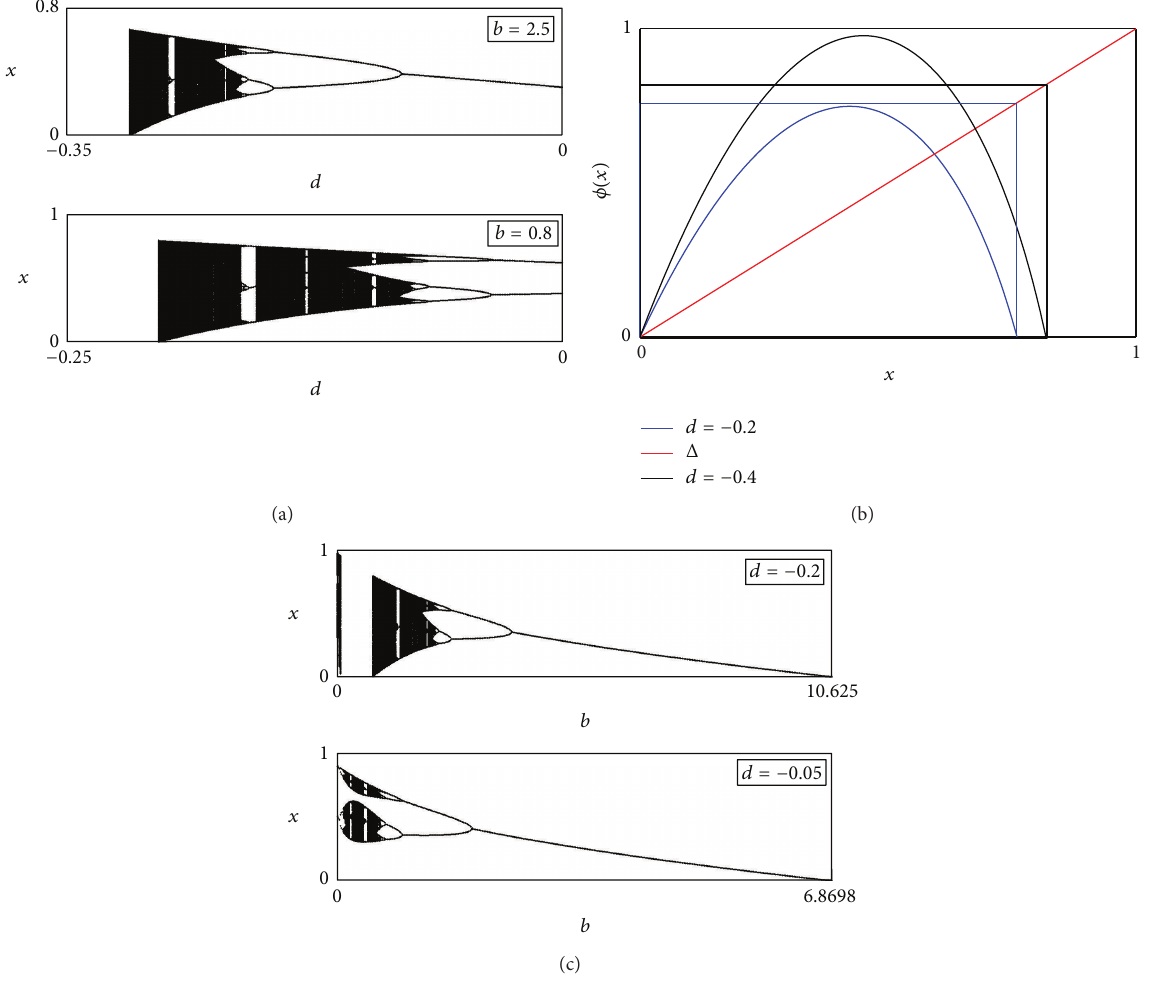
Figure 3: Parameter values: 𝑤 = 0.5 , 𝛼 = 1.5 . (a) One-dimensional bifurcation diagrams with respect to 𝑑 for two fixed 𝑏 values. (b) Map 𝜙 is plotted for different 𝑑 values and 𝑏 = 1 . (c) One-dimensional bifurcation diagrams with respect to 𝑏 (0 < 𝑏 < 𝑏) for two fixed 𝑑